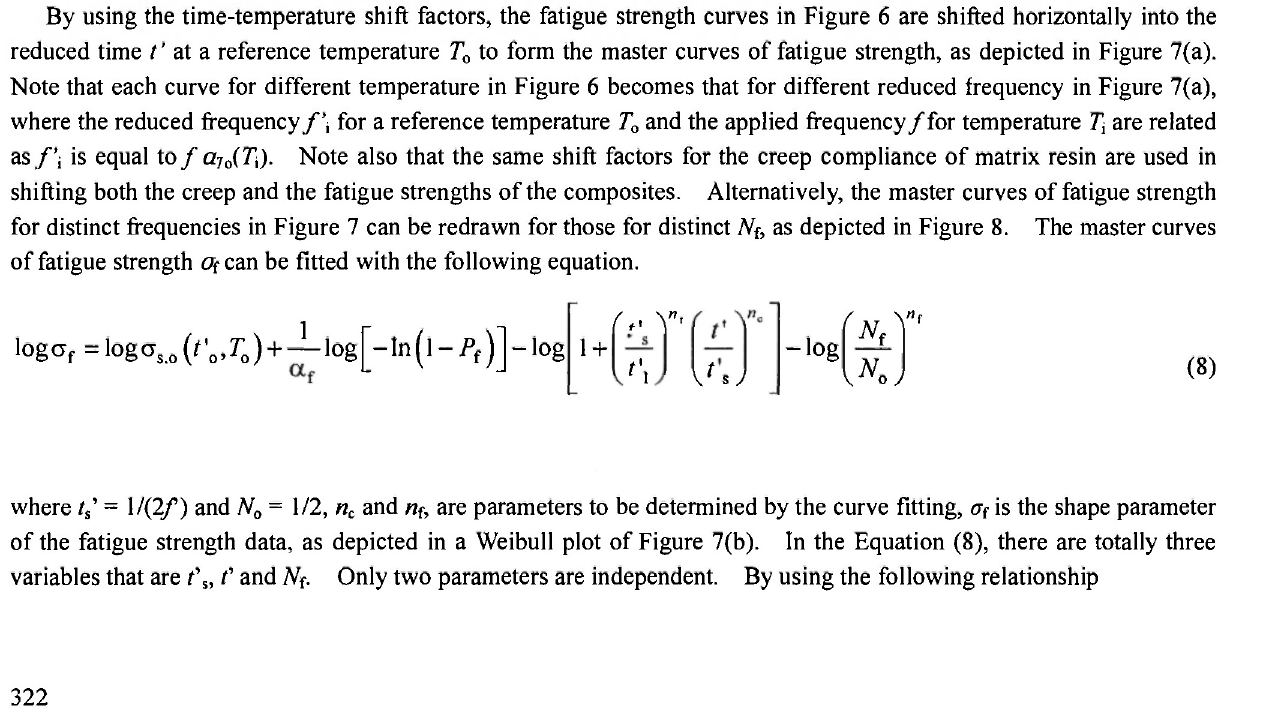
Fig. 8: Master curve of fatigue strength for distinct numbers of cycles to